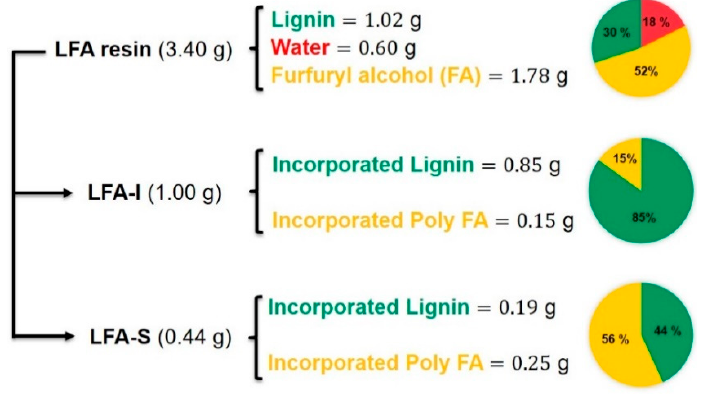
Figure 3. Material balance analysis for LFA resin.